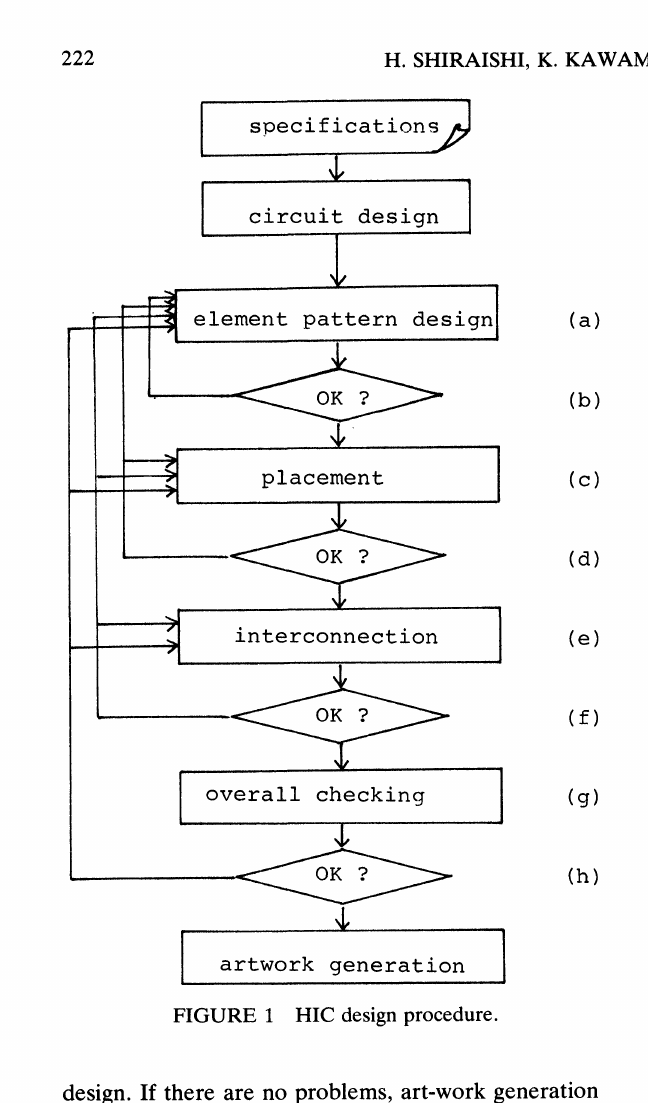
FIGURE HIC design